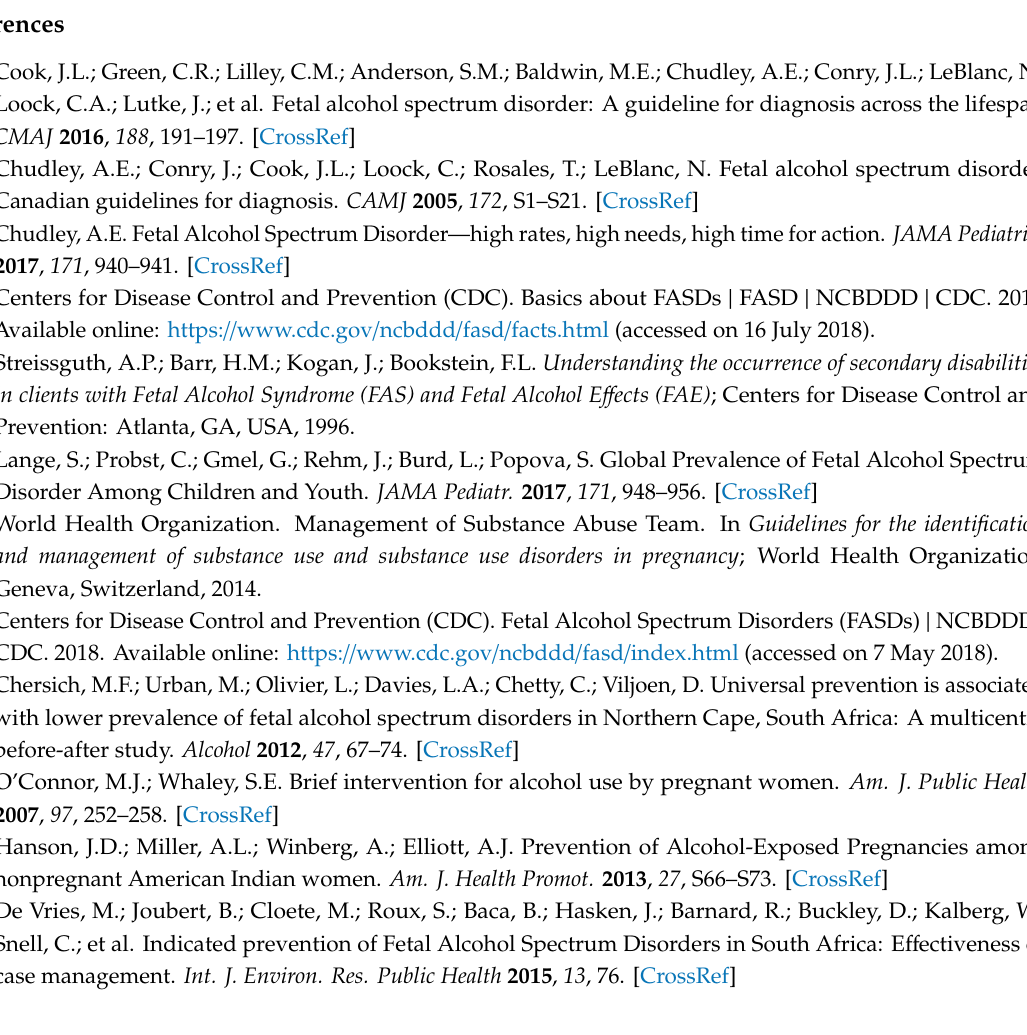
s2. Table S1: Quality assessment results for included studies, Table S2: Data extracted from the included studies. Author Contributions: Conceptualization, B.O.A., F.C.M. and C.E.; methodology, B.O.A., F.C.M. and